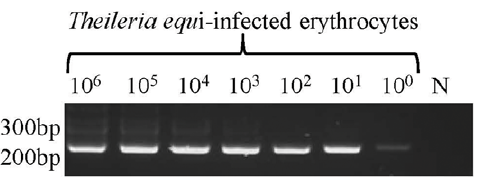
Figure 1. Sensitivity of nested PCR targeting Theileriaequiema - 1. A 2% agorose gel showing ema -1 amplicons from serial 10-fold dilutions of Theileria equi infected erythrocytes. N: negative control. The position of the molecular size markers are indicated on the